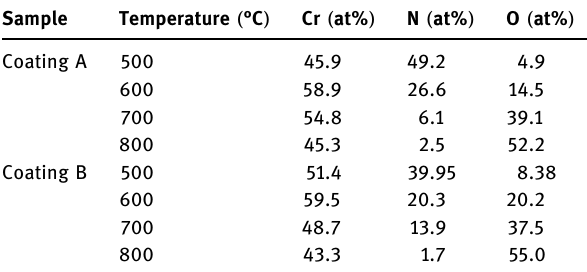
Table 2: Chemical compositions of the CrN/N coatings ’ surface oxidized at di ff erent temperatures Sample